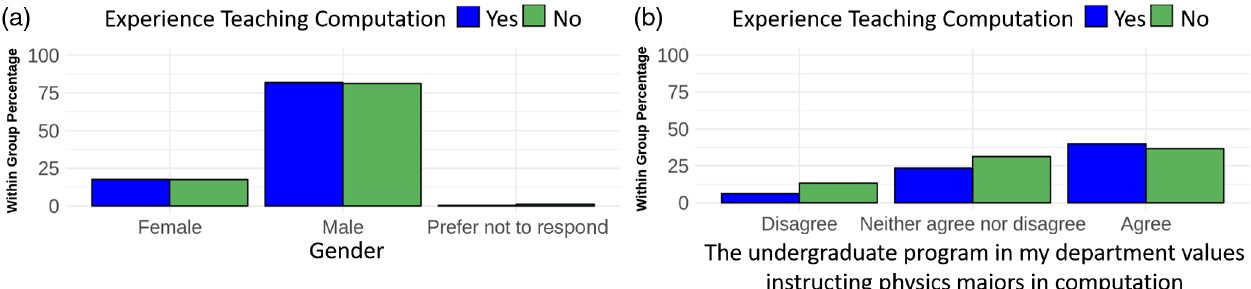
FIG. 4. Distribution of responses based on whether faculty do or do not have experience teaching computation. Here, within group percentage means the percentage of faculty within the group who use computation or the group who does not use computation. Since these two variables are less useful for predictions, we expect that the distribution of responses should not be different between faculty with experience teaching computation and those who do